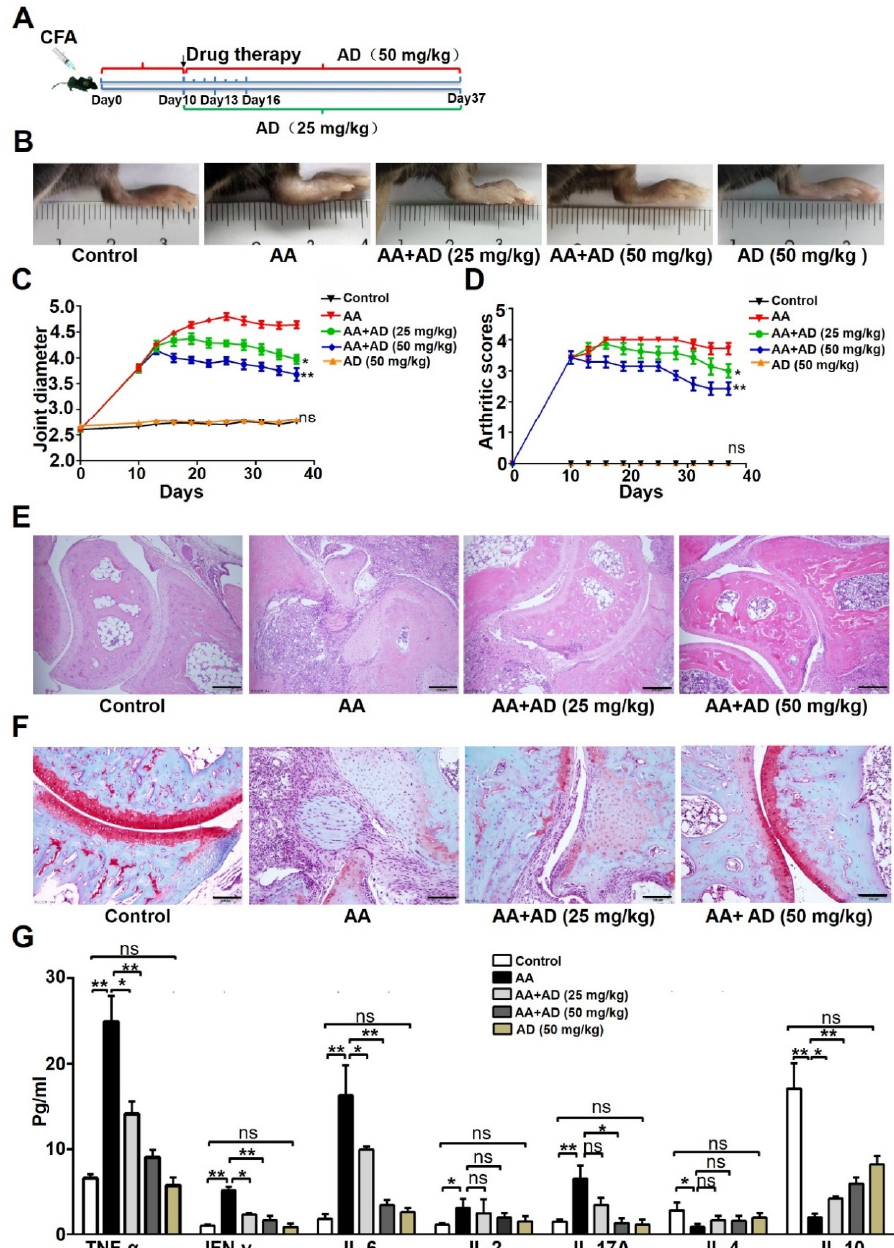
Figure 1. Andrographolide (AD) ameliorated adjuvant-induced arthritis in mice. ( A ) Schematic diagram of the study. ( B ) Representative pictures of the mouse hind paw on day 37. ( C ) Joint swelling was assessed by measuring the ankle joint diameter with a pocket thickness gauge ( n = 10). Data are presented as the means ± SD. ( D ) The severity of arthritis was graded using a 0–4 arthritis scoring criterion: 0—normal, 1—slightly redness or swelling of the ankle joint, 2—moderate swelling and slightly activity limited, 3—obvious swelling and activity limited, and 4—severe swelling and activity disorder. Data are presented as the means ± SD ( n = 10). ( E ) Hematoxylin and eosin staining of ankle joint sections of each treatment group on day 37. Images of representative sections are shown. ( F ) Assessment of articular cartilage damage by staining with Safranin O-fast green. Images of representative sections are shown. ( G ) The cytokine protein levels in the plasma of AA mice were measure using a Cytometric Bead Array (CBA) Human Chemokine Kit ( n = 10). Data represent mean ± SD ( n = 10). * p < 0.05, ** p < 0.001. CFA: Complete Freund’s adjuvant; AA: adjuvant-induced arthritis; TNF: tumor necrosis factor, IFN: interferon; IL: